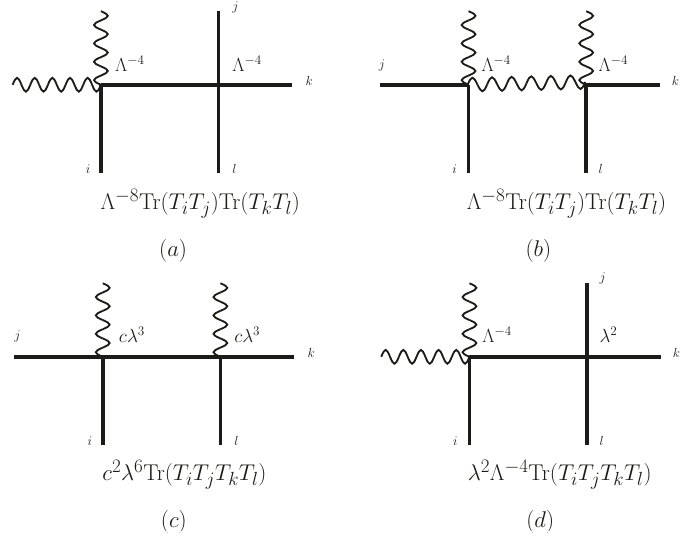
Figure 2 . Four Feynman diagrams contributing to the scattering of four scalars and two photons in the extended DBI theory with generic coupling c